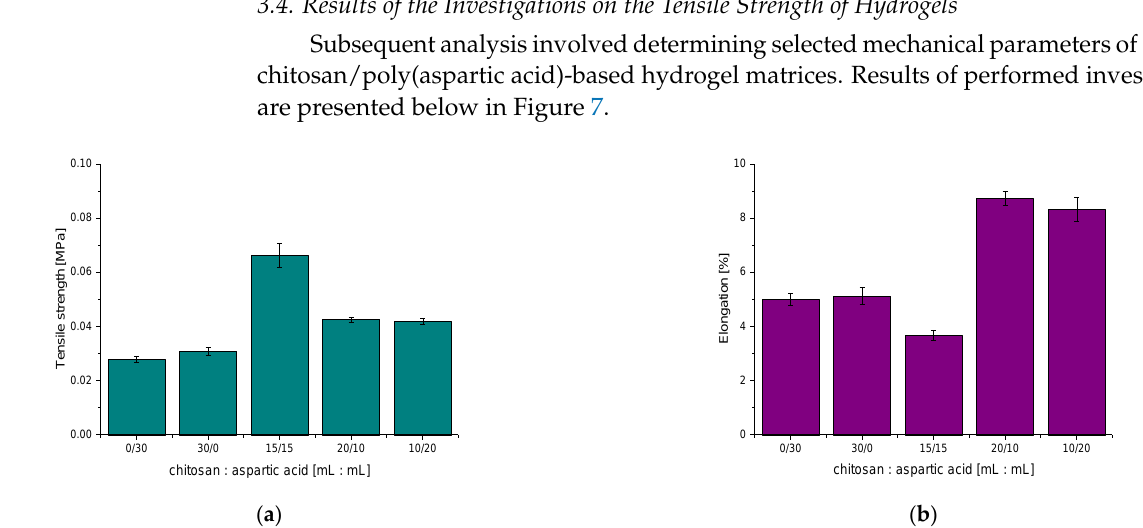
Figure 7. Results of mechanical studies showing the tensile strength ( a ) and the elongation ( b ) of hydrogel matrices under the tension applied.